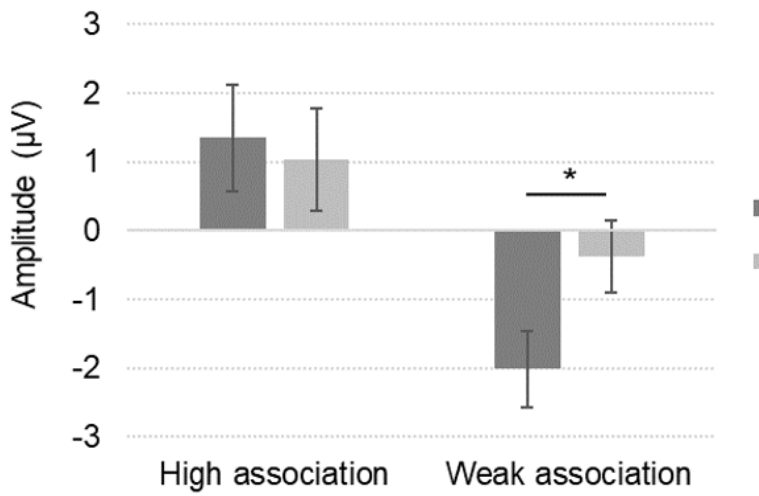
Figure 4. Mean N400 amplitude ( ± SEM ) as a function of age group and semantic association in the reviewed studies ( n = 21). * p < 0.05.